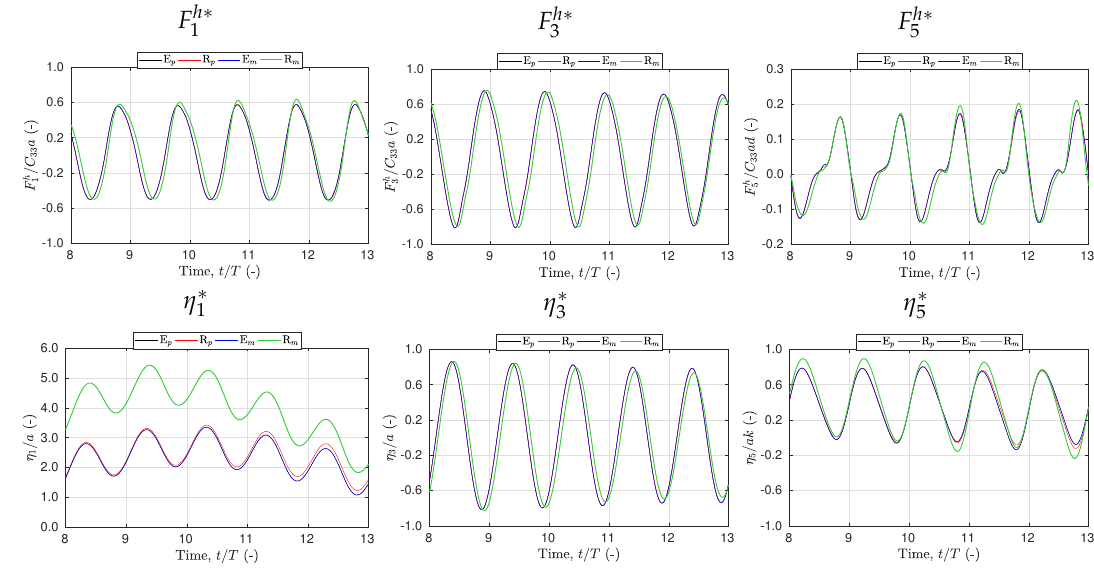
Figure 5. Time histories of hydrodynamic forces ( top row) and the motion response ( bottom row) in W1 for Euler (E) and RANS (R) simulations at prototype (p) and model (m)